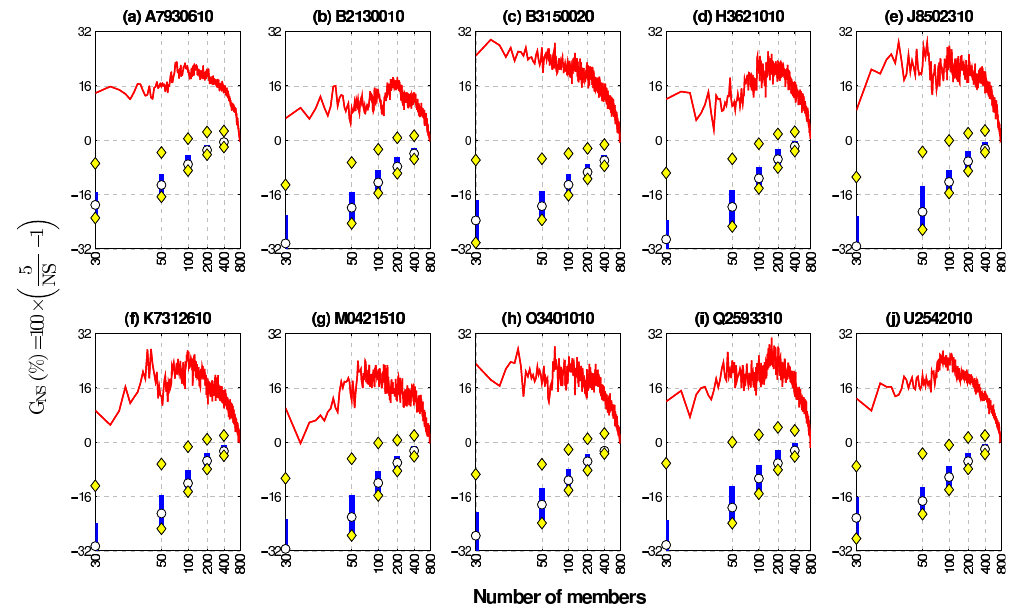
Fig. 4. Evolution of the normalized sum (NS) in terms of gain index for the lead time 9, optimization with the combined criterion. Loga- rithmic scale on the x-axis. The normalized sum equal to 5 represents the performance of the initial 800-member ensemble. The thin red line represents the normalized sum under different numbers of members found with BGS. Symbols for the 200 random selection experi- ments: the blue vertical line identifies the interquartile range, white circles represent the median and yellow diamonds corresponding to the percentiles 10 and 90.